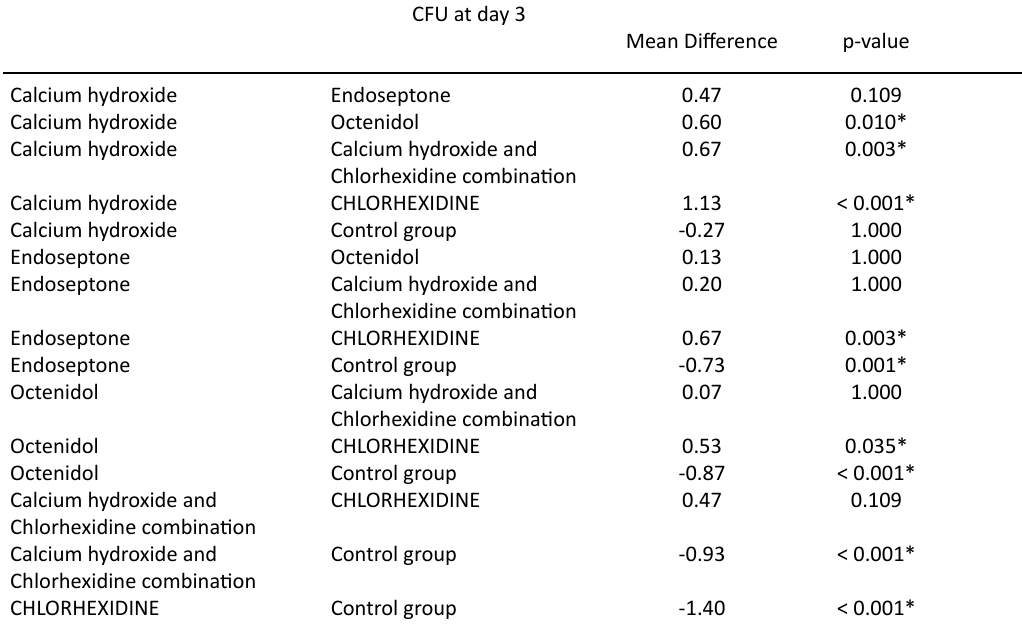
Table 8. Mean difference of CFU between various medicaments